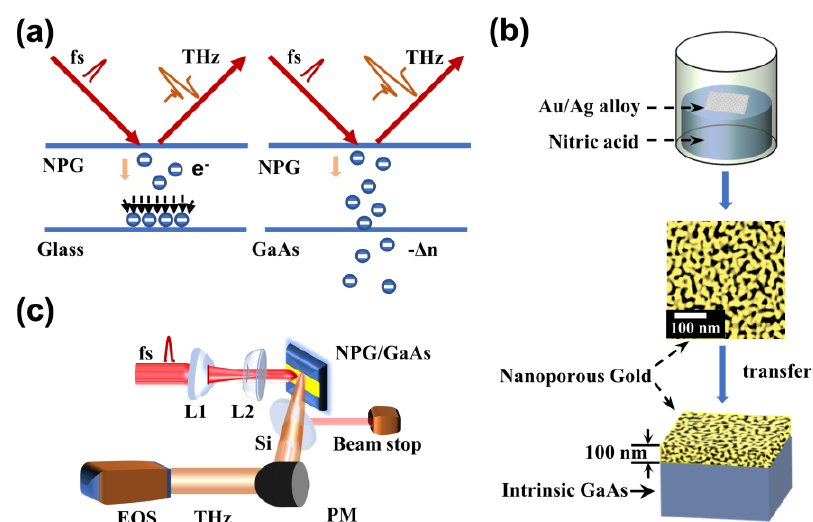
Figure 1. The schematic diagram of enhanced terahertz radiation and setups in our experiment. ( a ) Different processes of free charges were influenced by femtosecond laser between nano-porous gold (NPG)/glass and NPG/GaAs. Laser beam was irradiated on the surface of the NPG films, which were deposited separately on the glass slide and GaAs; ( b ) The synthesis of NPG/GaAs. The surface morphology of the NPG films was imaged by scanning electron microscope (SEM; JEOL JIB-4600F, Japan); ( c ) Schematic diagram of the experimental setup for detection of THz radiation: EOS, electro-optic sampling; PM, parabolic mirror; THz, terahertz radiation; L1, convex lens; L2, concave